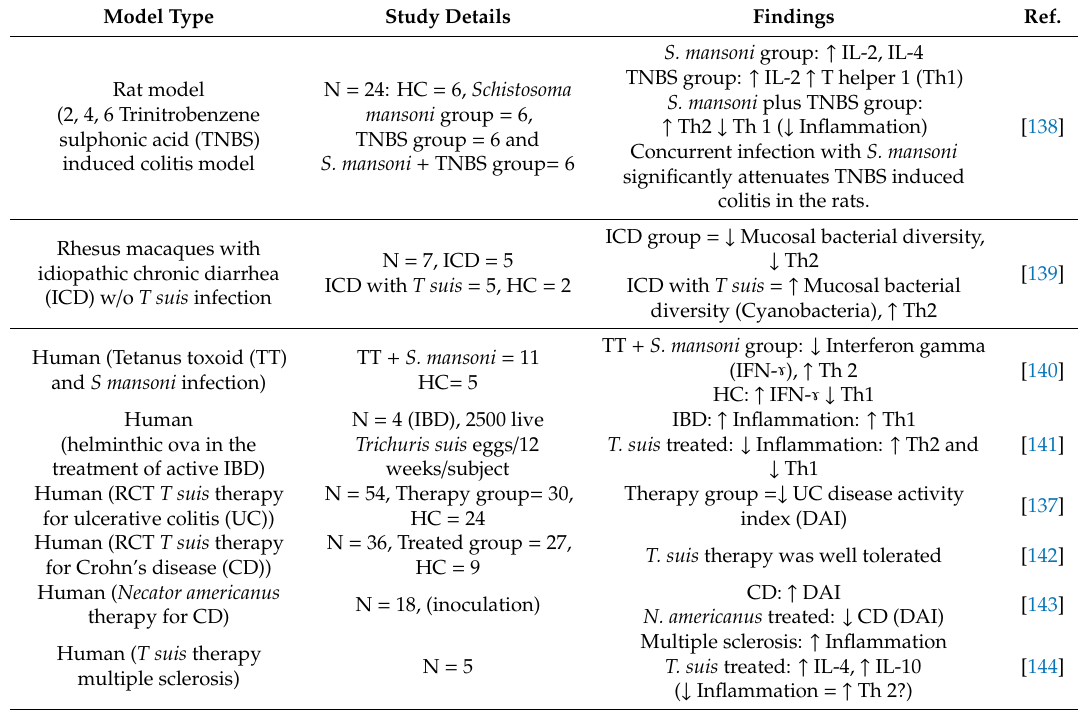
Table 7. Summary of significant study findings on the role of helminths in health and disease.